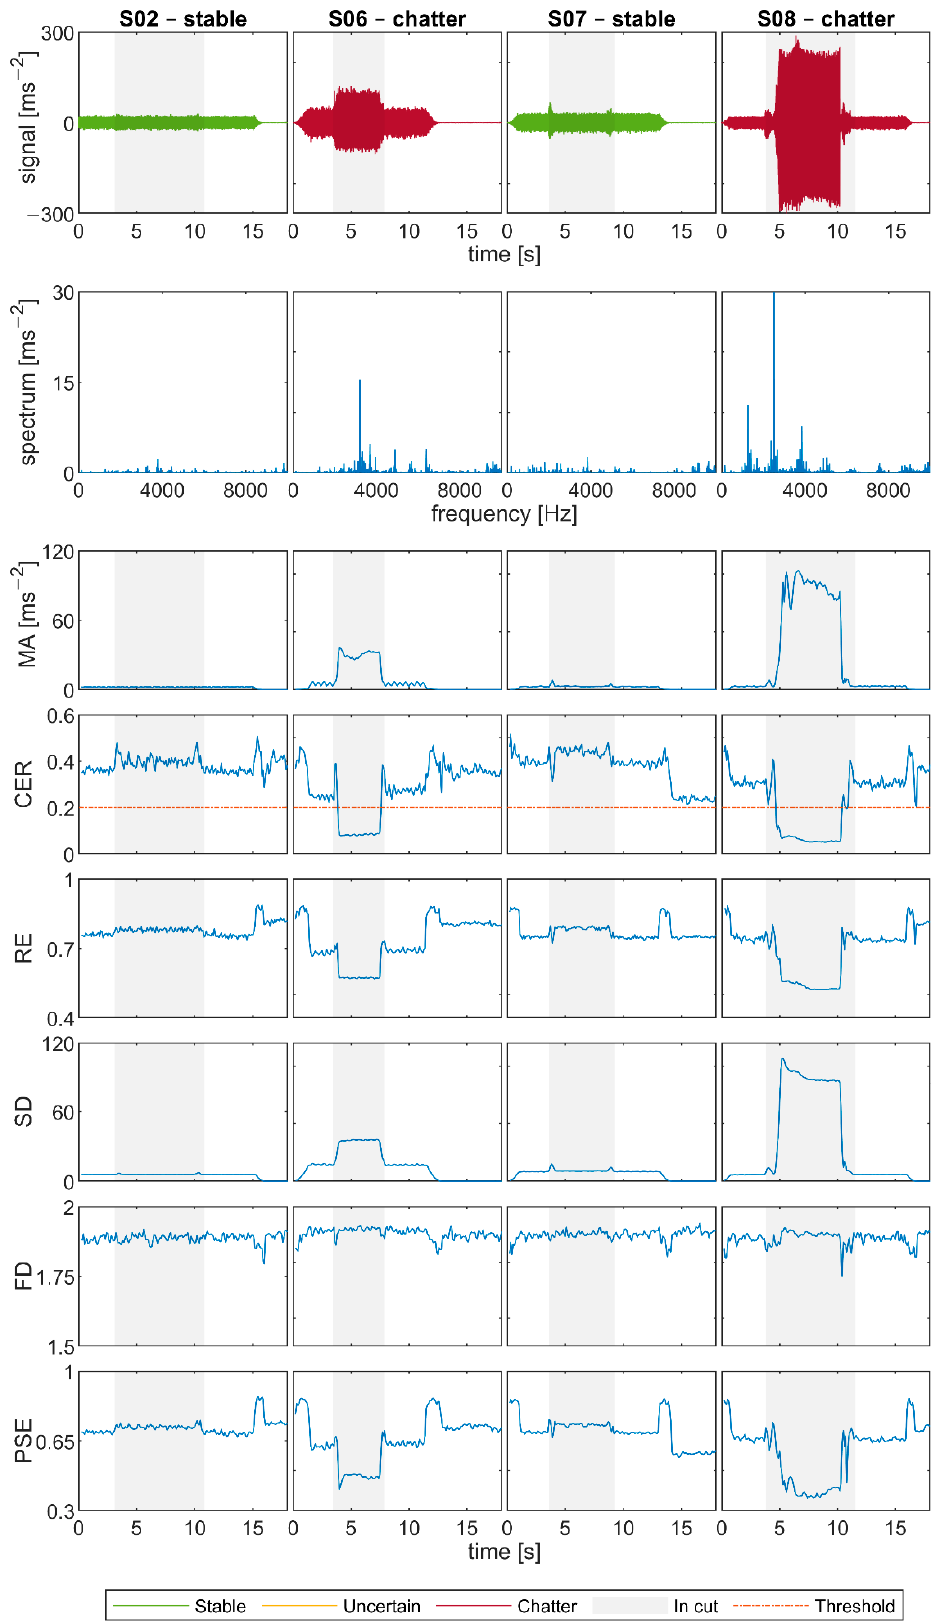
Figure 10. Signals from Experiment 1, slender end mill, overhang 50 mm: stable signal S02, chatter in signal S06. Signals from Experiment 2, slender end mill, overhang 30 mm: stable signal S07, chatter in signal S08.